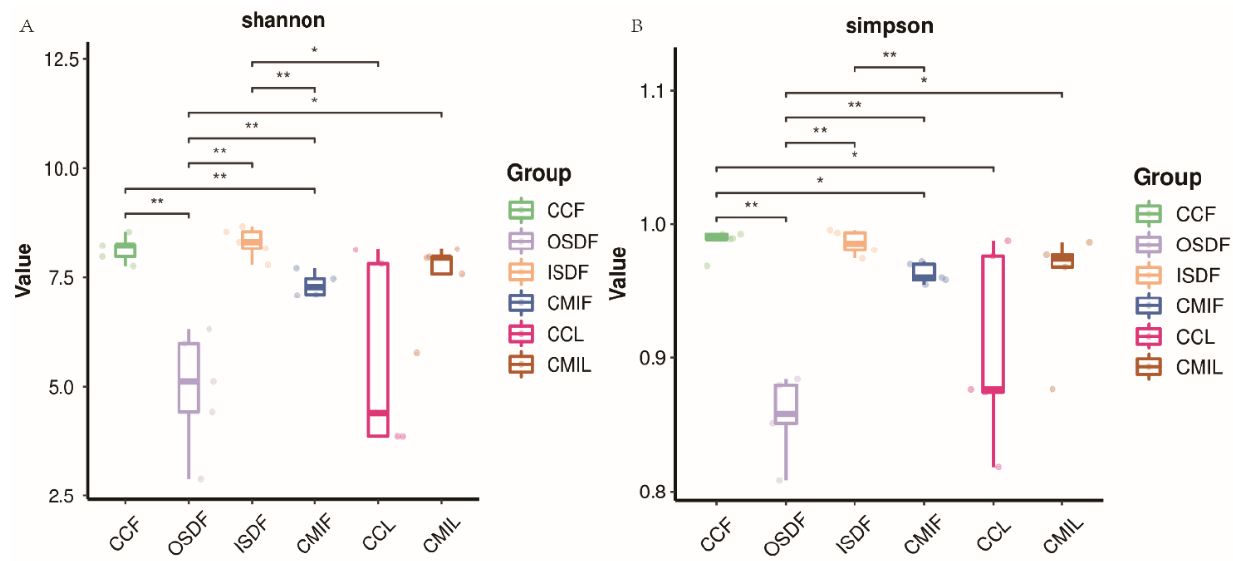
Figure 5. Plots of Alpha diversity indices of grouped H. flava and H. longicornis samples. Plot ( A ) the Shannon diversity index and plots ( B ) the Simpson diversity index (* p < 0.05, ** p < 0.01). The groups of H. flava are CCF, OSDF, ISDF and CMIF and the groups of H. longicornis are CCL and CMIL.